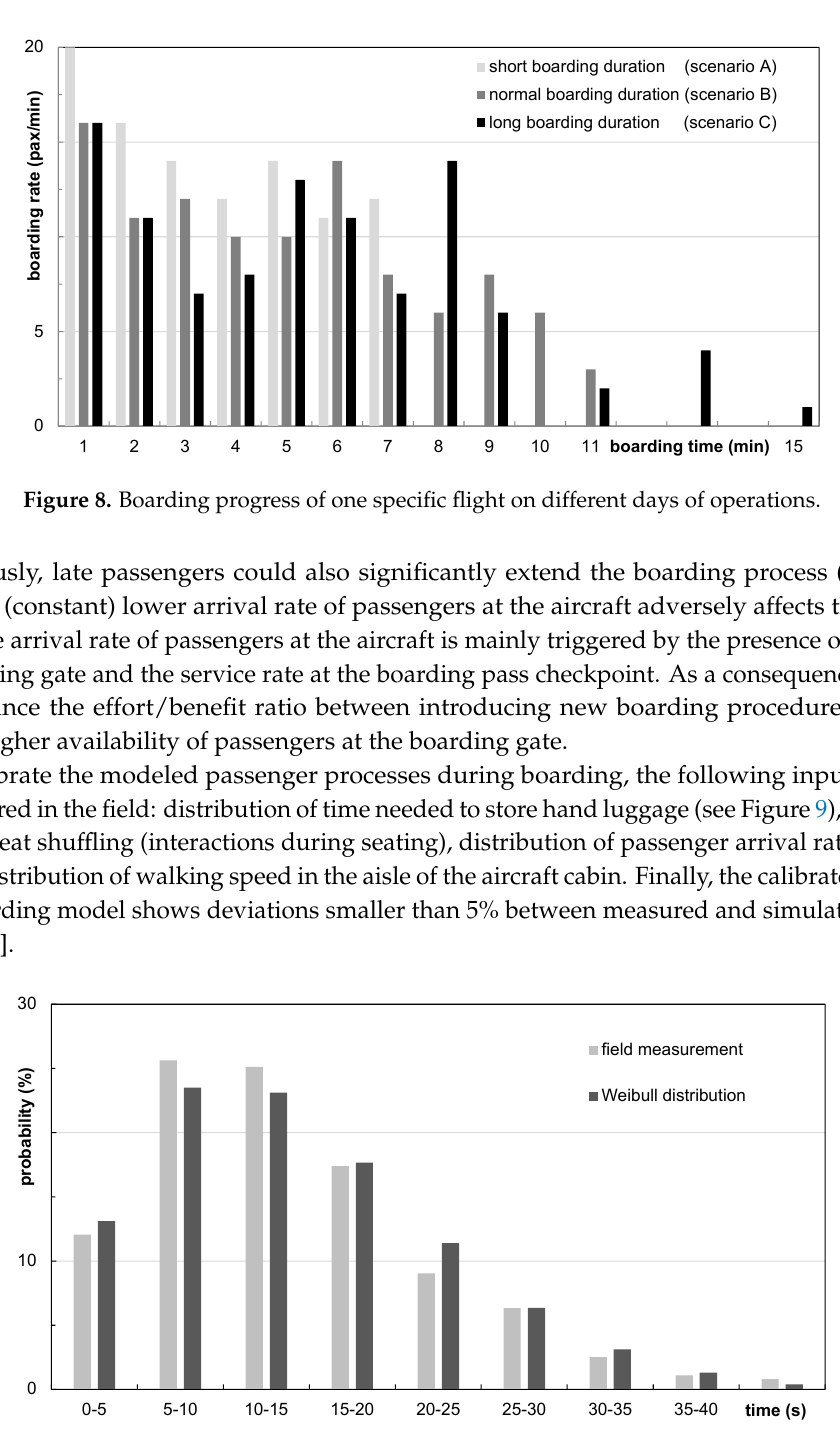
Figure 9. Distribution of time needed to store hand luggage: comparison of field measurements and Weibull distribution.